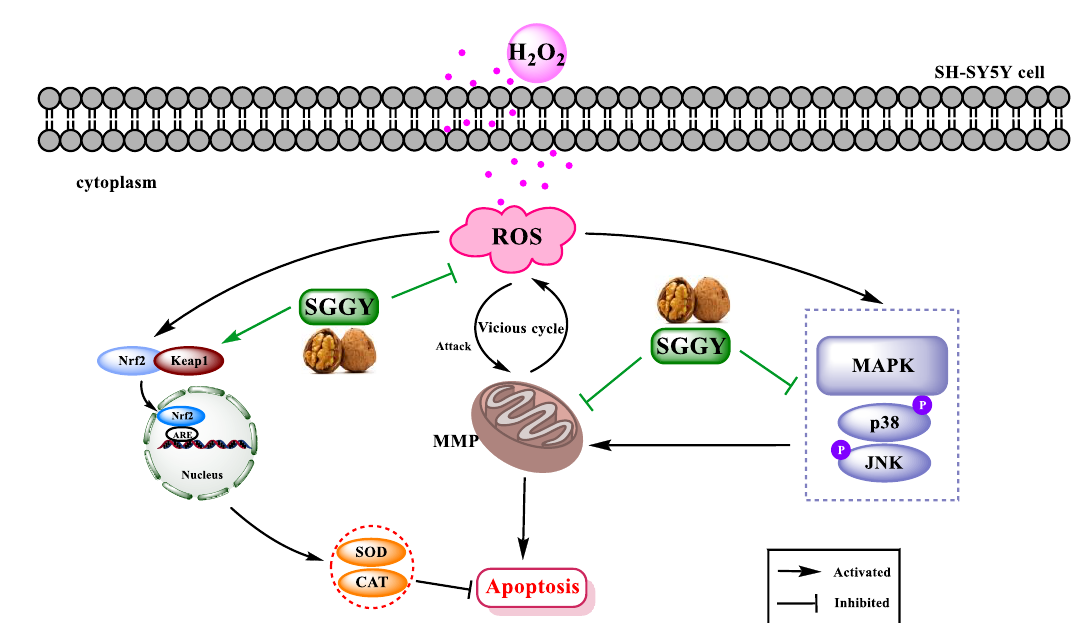
Figure 7. Molecular mechanism of SGGY-suppressed H 2 O 2 -induced SH-SY5Y cells’ cytotoxicity. H 2 O 2 increases the level of intracellular ROS, and then the oxidative stress induced by H 2 O 2 triggers the JNK, p38, and Nrf2 signaling pathways. While SGGY pre-treatment attenuates the generation of intracellular ROS and dysfunction of mitochondria, it suppresses the phosphorylation of JNK and p38 and promotes the nuclear translations of Nrf2 to improve the antioxidant capacity of cells, thereby enhancing the activity of cells. The arrows in green highlight the primary roles of SGGY in protecting SH-SY5Y cells from H 2 O 2 -stimulated oxidative stress.